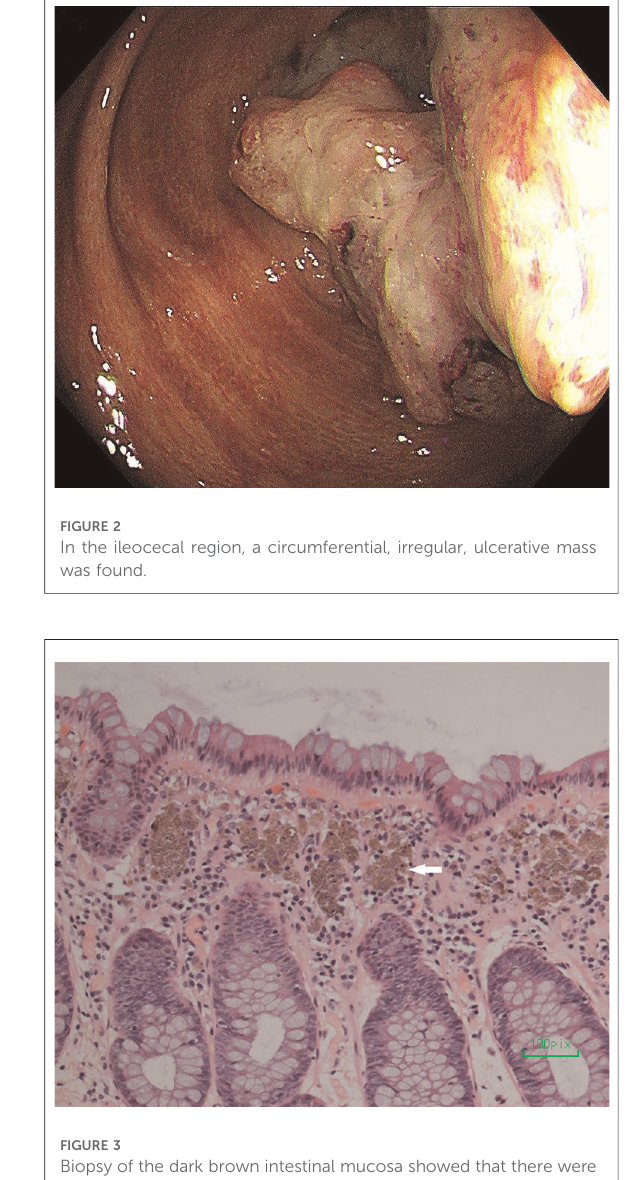
FIGURE 1 The colonoscopy revealed a colon that was diffusely fi lled with dark brown pigmentation in a snakeskin-like pattern.